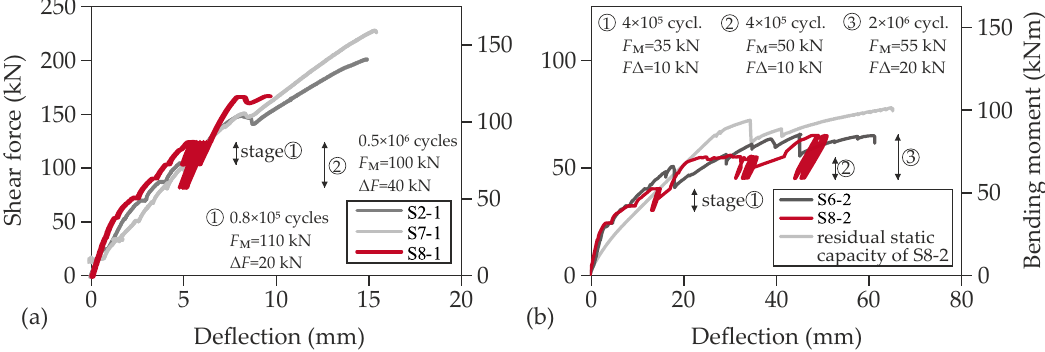
Figure 15. Comparison of load-deflection curves of cyclic (S8) and static tests (S2, S6 und S7). F M = mean load, ∆ F = peak-to-peak amplitude: shear test ( a ) and flexural test ( b ).